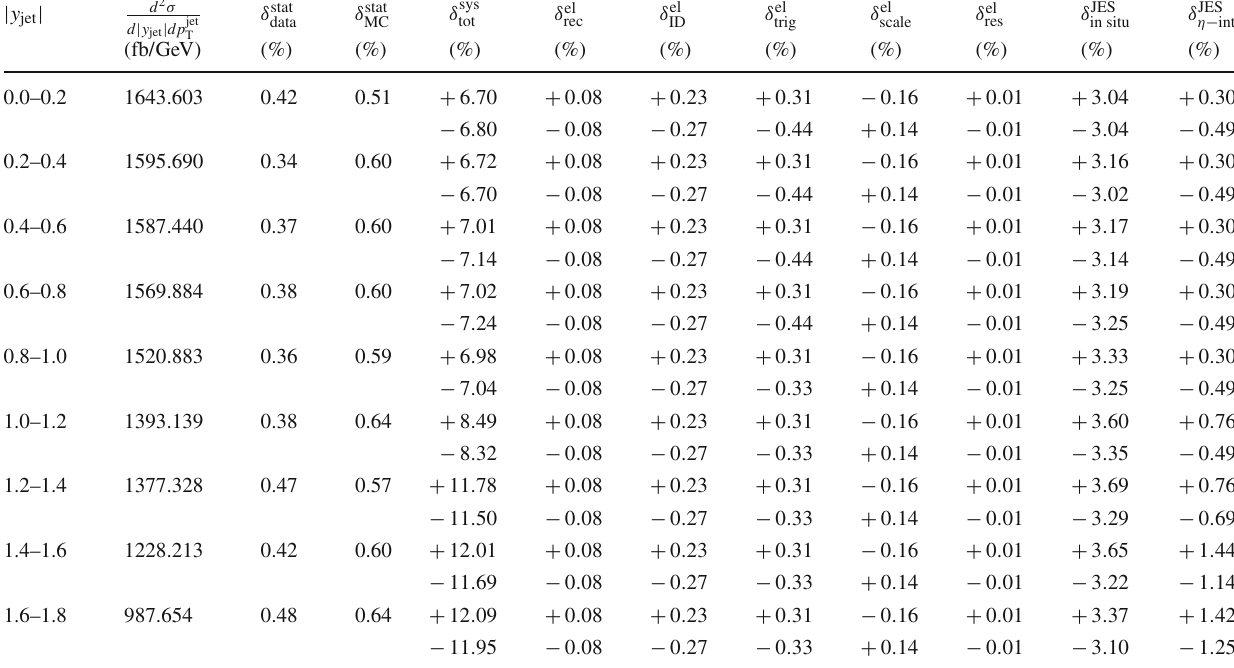
Table 3 The measured double-differential Z + jets production cross- sections as a function of | y jet | in the 25GeV < p jet δ stat and δ stat are the statistical uncertainties in data and MC simulation, data MC respectively. δ sys tot is the total systematic uncertainty and includes the fol- lowing components: uncertainties due to electron reconstruction ( δ el rec